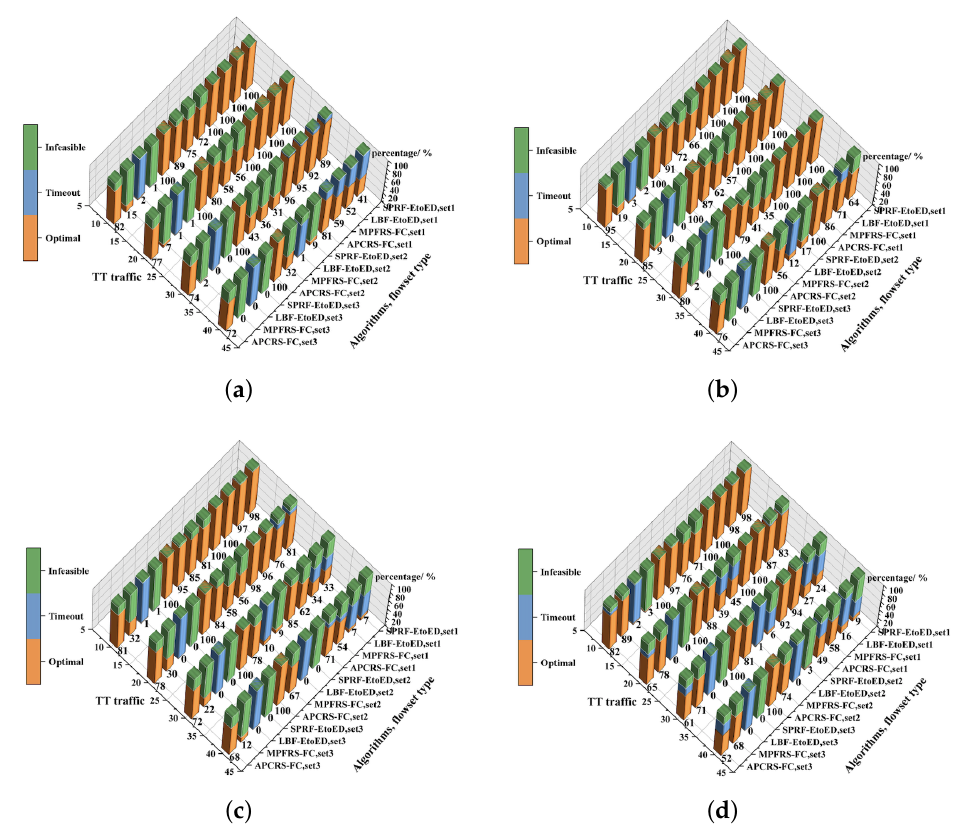
Figure 6. Percentage distribution of optimal, timeout, and infeasible instances of SPRF-EtoED, LBF-EtoED, MPFRS-FC, and APCRS-FC for different network topos and different number of flows. ( a ) Topo 1: small ring. ( b ) Topo 2: small mesh. ( c ) Topo 3: medium ring. ( d ) Topo 4: medium